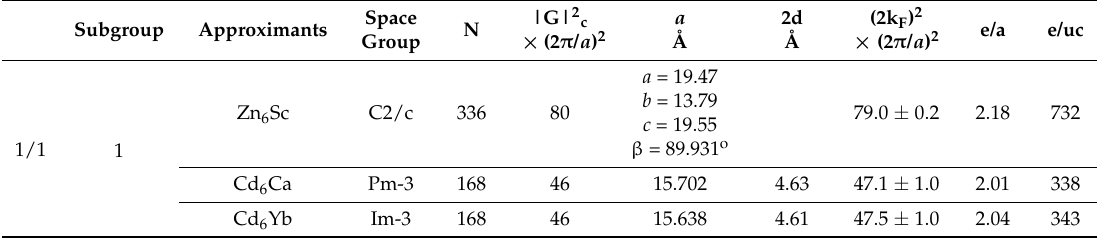
Table 6. Hume-Rothery electron concentration rule for Tsai-type 1/1-1/1-1/1